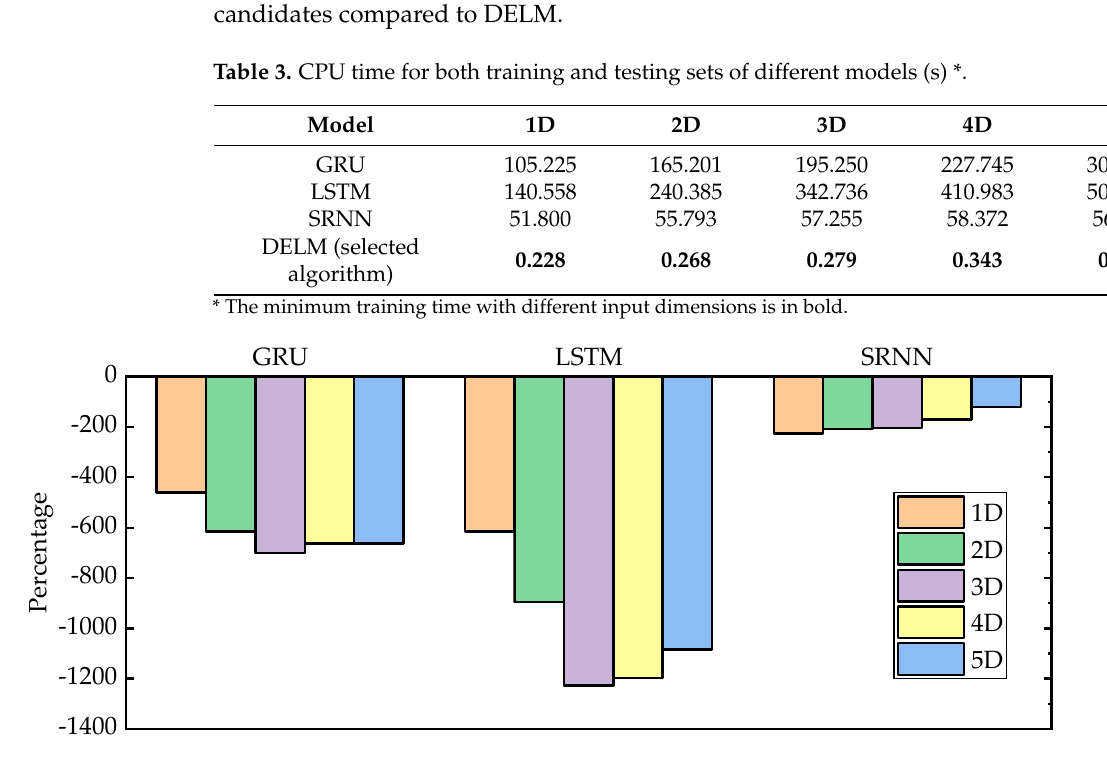
Figure 9. The efficiency improvement percentage of three candidates compared to DELM.